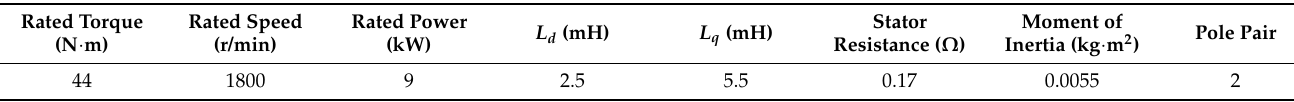
Table 1. Parameters of